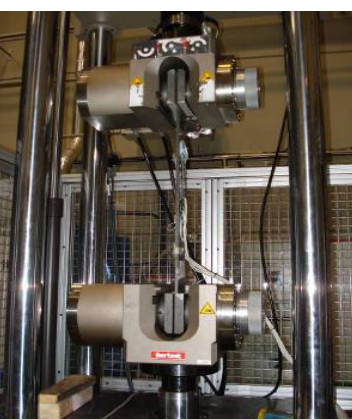
Figure 4. T/C machine used on